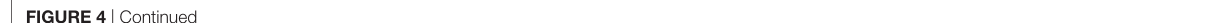
FigUre 4 | Continued Immunomodulatory effect of farnesylthiosalicylic acid (FTS) treatment on the induction of Th1, Th17, and Treg subsets post CFA immunization. (a) Representative flow cytometry plots of intracellular staining for Th1 and Th17 cytokines producing CD4 + T cells. (B) Bars represent the percentage (mean ± SD) of the indicated Th-subsets in spleens of the various rat groups harvested at day 20 post CFA immunization ( n = 5 per group). (c) Representative flow cytometry plots for Treg cells identification (CD3 + CD4 + FoxP3 + events). (D) Left hand Bars graph represent the percentage (mean ± SD) of Treg cells in the various rat groups ( n = 5 per group). Right hand plot represents the Treg to Th17 ratio in these rats. Statistical significance was assessed by one way ANOVA with post hoc Bonferroni’s